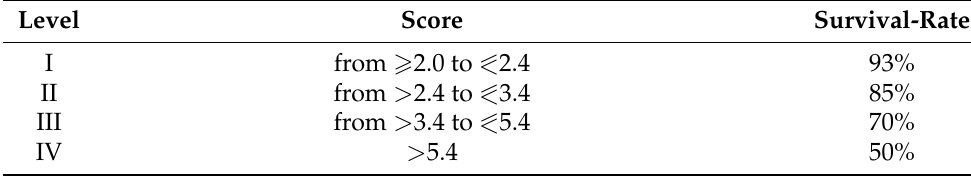
Table 1. NPI levels and their 5-year survival